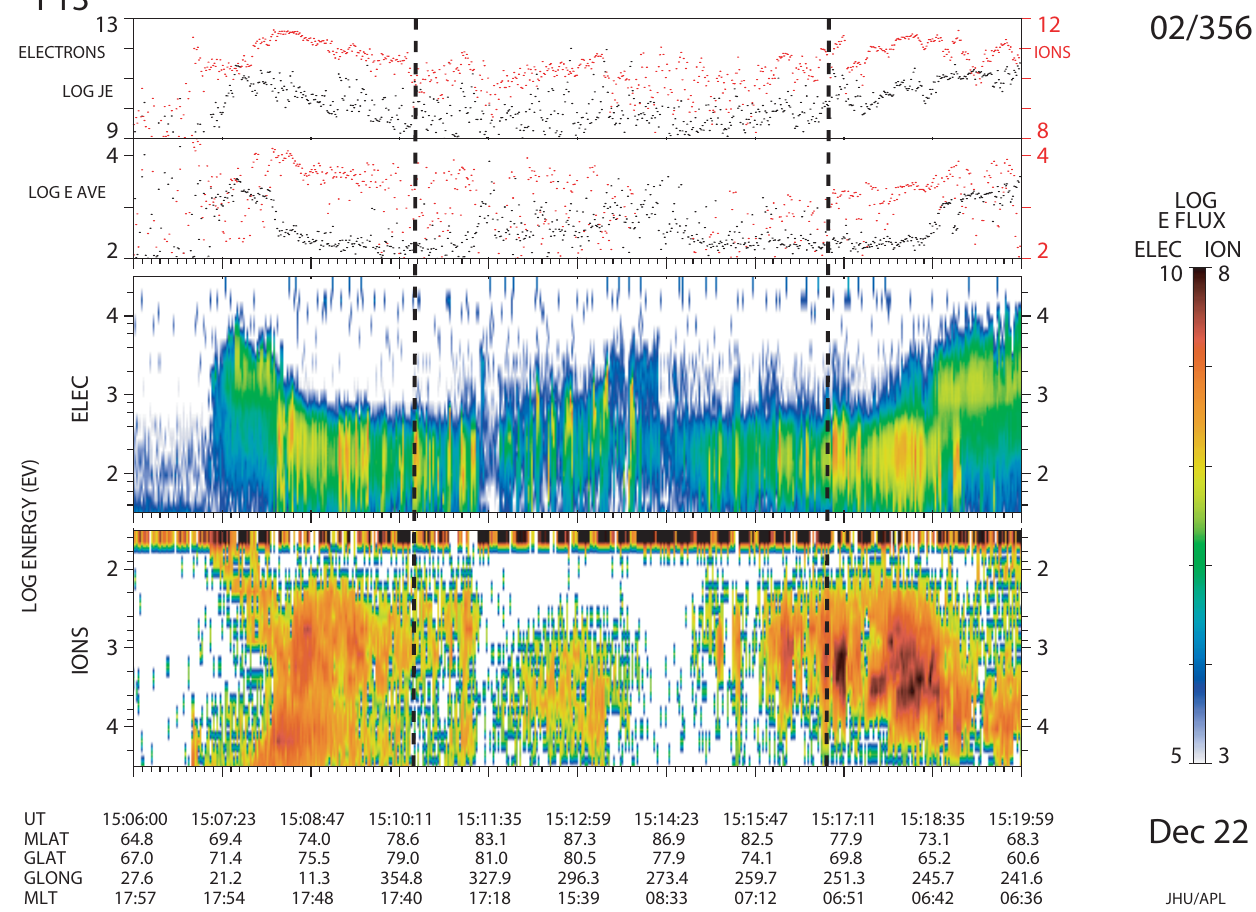
Fig. 14. Spectrogram from the DMSP F13 spacecraft for the time interval 15:06 to 15:20 UT. The two black dashed lines on the plot indicate boundaries between open and closed field